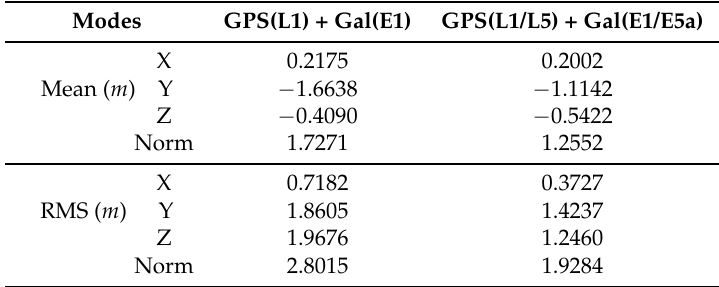
Table 2. Statistics of positioning errors in the ECEF coordinate (basketball court).